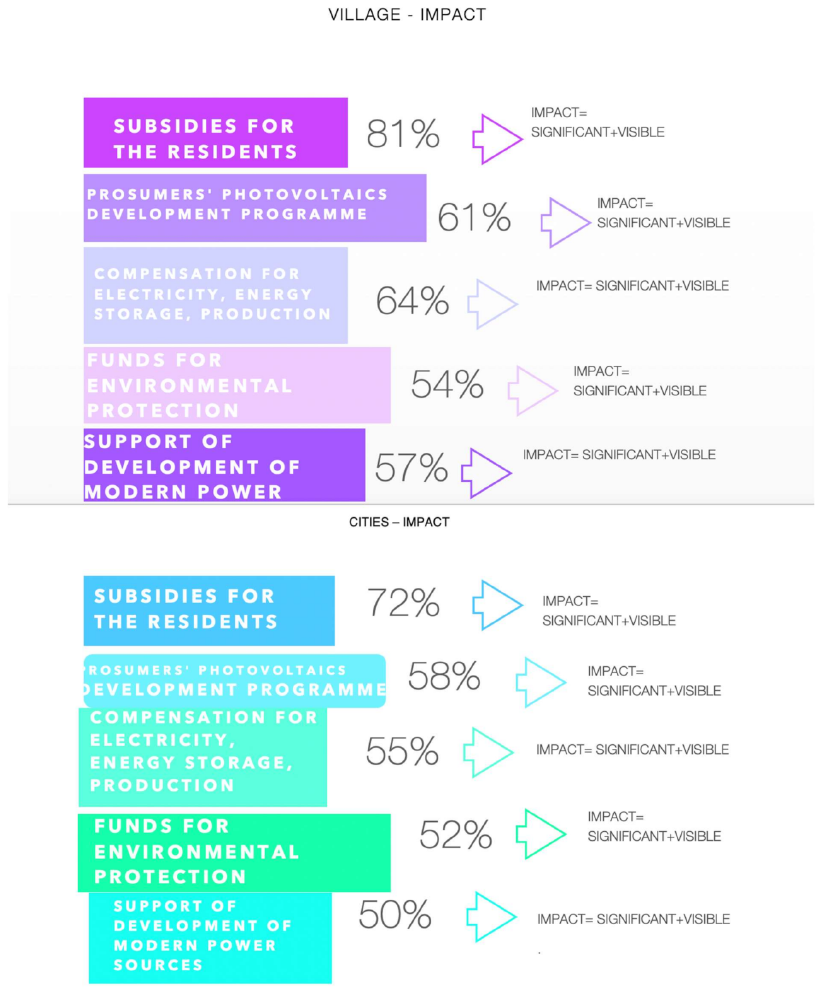
Figure 2. Respondents’ opinions on the activities transferred from central to local (Question 2: (Which of the following activities should be transferred from central to local)). Source: Own research based on the results of an online survey, n = 444 (444 respondents who filled in the questionnaire online, of which 205 were men and 239 were